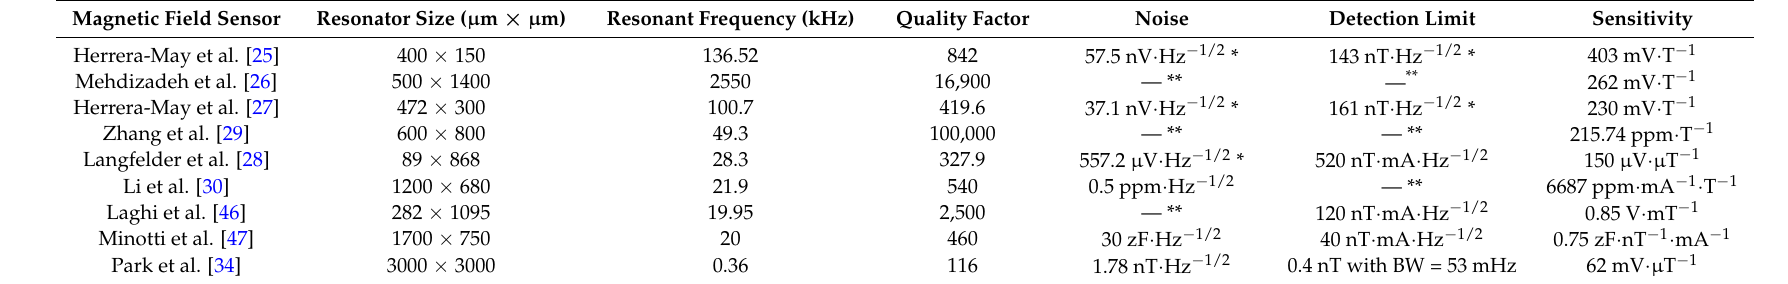
Table 1. Main characteristics of recent MEMS magnetic field sensors based on Lorentz